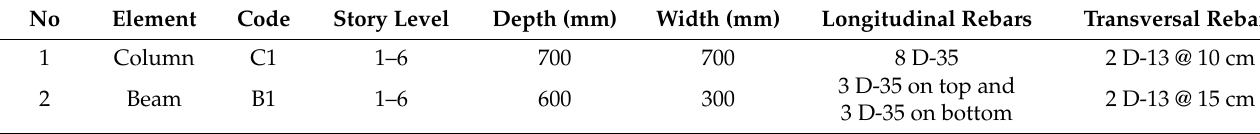
Figure 14. Generic frame structures of towered setback model. Table 4. Section details of column and